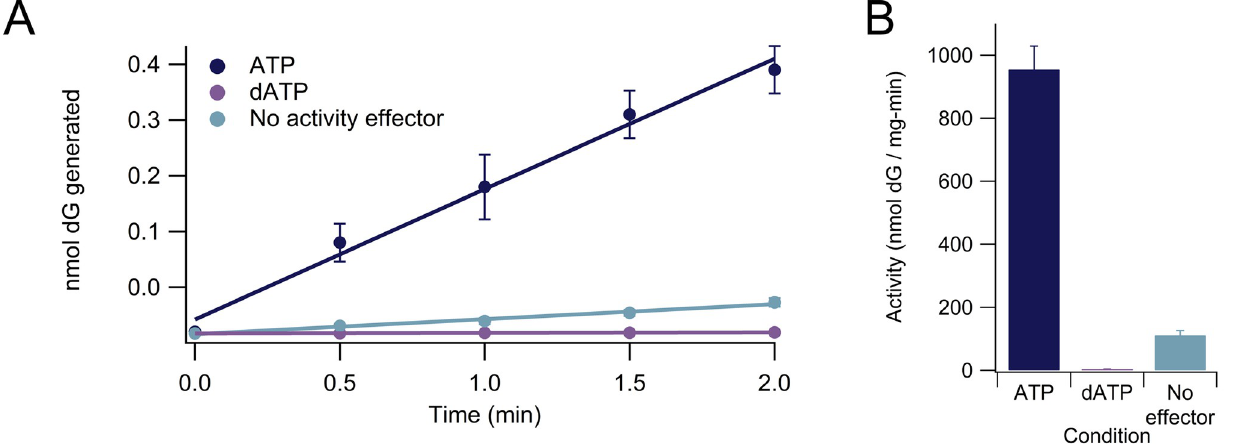
Fig 5. Activity of St NrdD class III ribonucleotide reductase enzyme. (A) Activity assay data for ATP, dATP, and no allosteric activity effector in the presence of GTP (substrate) and TTP (specificity effector). Error bars are shown for all replicates (3 replicates per data point) but are too small to visualize for some conditions. (B) Activities calculated from assay data in (A). Each bar represents average activity +/- standard error of the mean for three replicates. All conditions contained 0.10 μ M St NrdD with 1.5 ± 0.10 glycyl radicals/dimer, 1 mM substrate GTP, 1 mM specificity effector TTP, 5 mM DTT, and 12.5 mM sodium formate; the ATP condition contained 3 mM allosteric activator ATP whereas the dATP condition contained 3 mM allosteric inhibitor dATP.